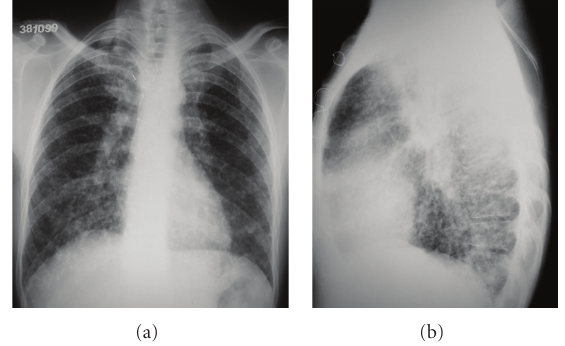
Figure 1: Chest radiographs in anteroposterior (a) and lateral (b) incidences showing infiltration by small nodules disseminated in both